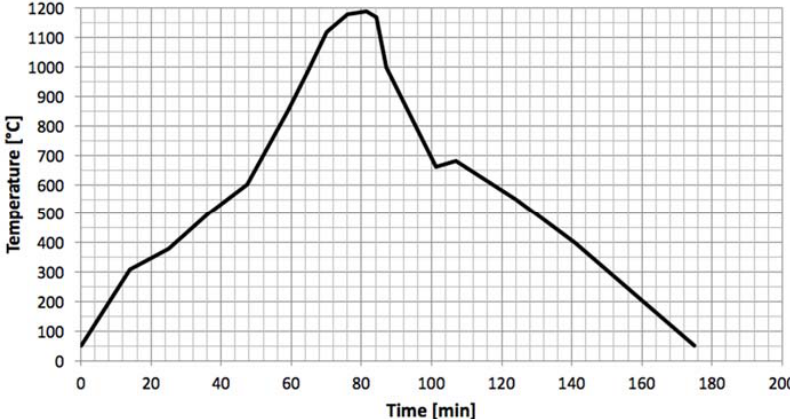
Figure 2. Annealing thermal cycle.